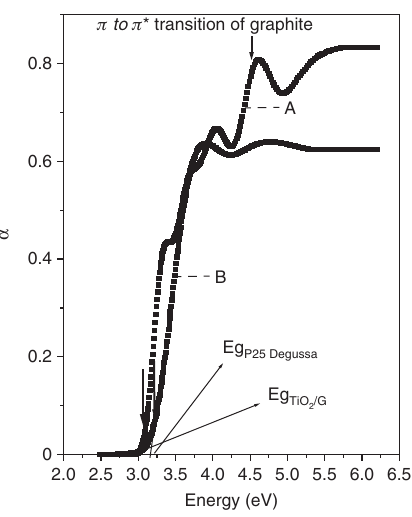
/G and (B) TiO Degussa 2 2